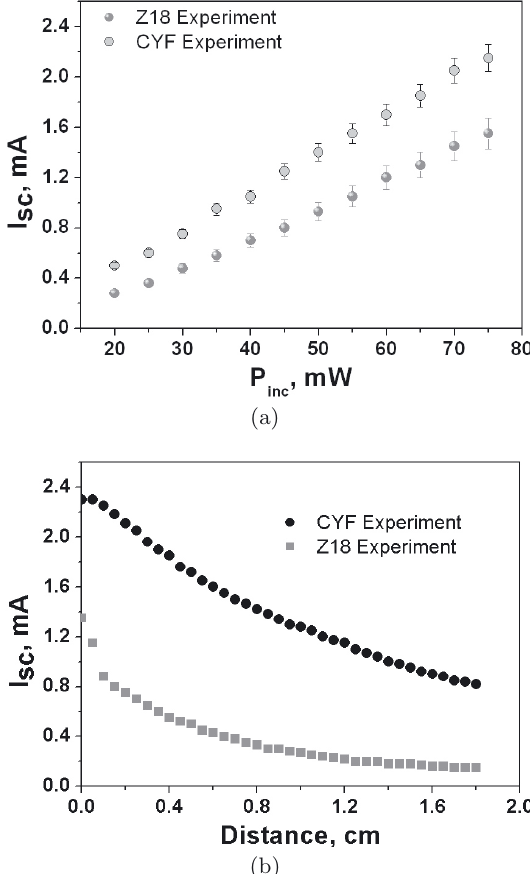
Fig. 5. Photocurrent generated in the bifacial c-Si solar cell measured by excitation at 1.54 μ m as a function of the excita- tion power (a) and as a function of the distance between the sample and the end fiber, the laser power was constant and set equal to 75 mW